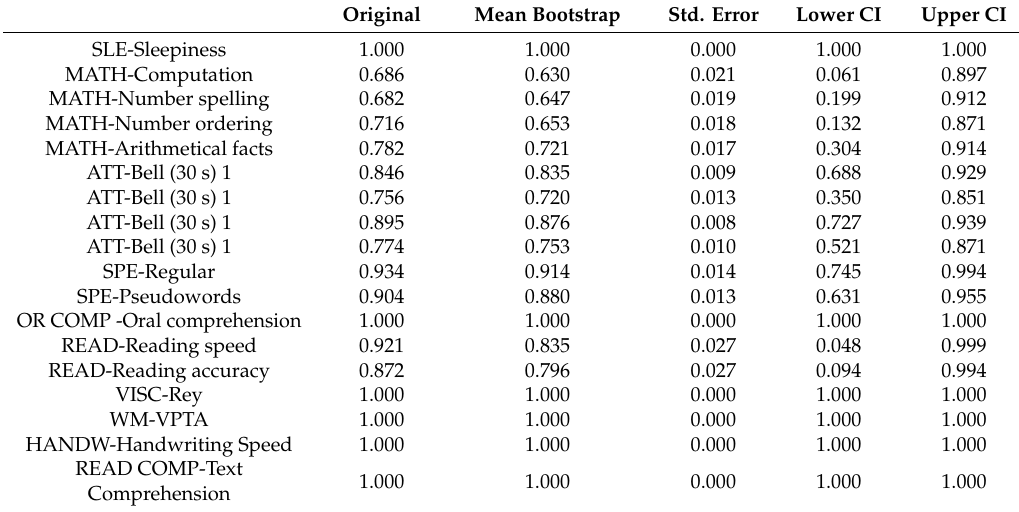
Table 6. Bootstrap validation of loadings between indicators and latent variables (outer